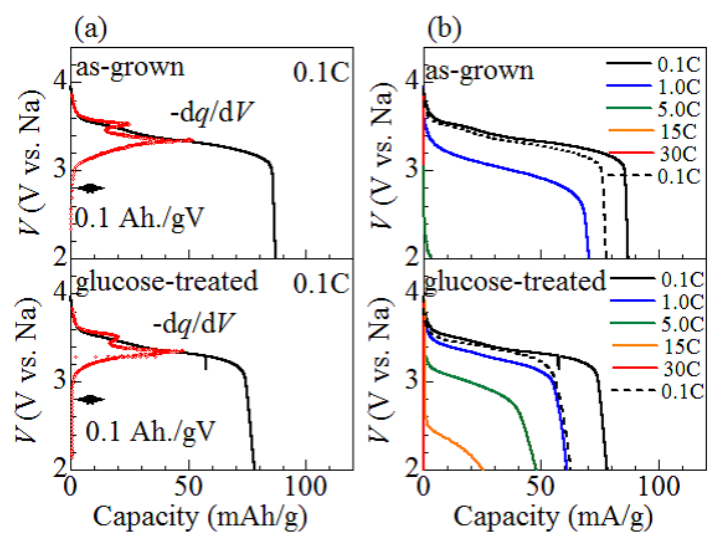
Figure 5. ( a ) Discharge curve at 0.1 C of as-grown and glucose-treated Mn-PBAs. Red circles are voltage-derivative of capacity (- d q /d V ; q and V are capacity and voltage, respectively); ( b ) Discharge curves at various discharge rate of as-grown and glucose-treated Mn-PBAs. The lower and upper cut-off voltages were 2.0 and 4.2 V, respectively. The charge rate was fixed at 0.3 C.